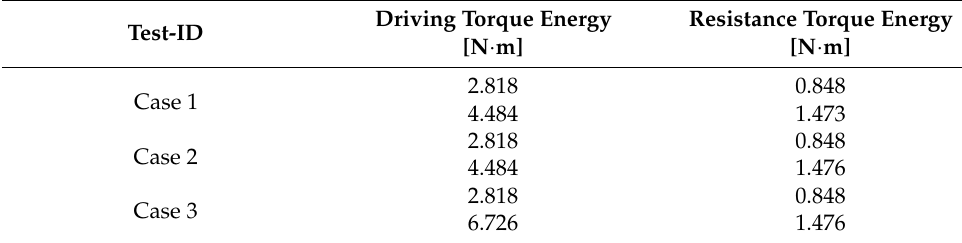
Table 10. Driving and resistance torque energy according to the test cases.